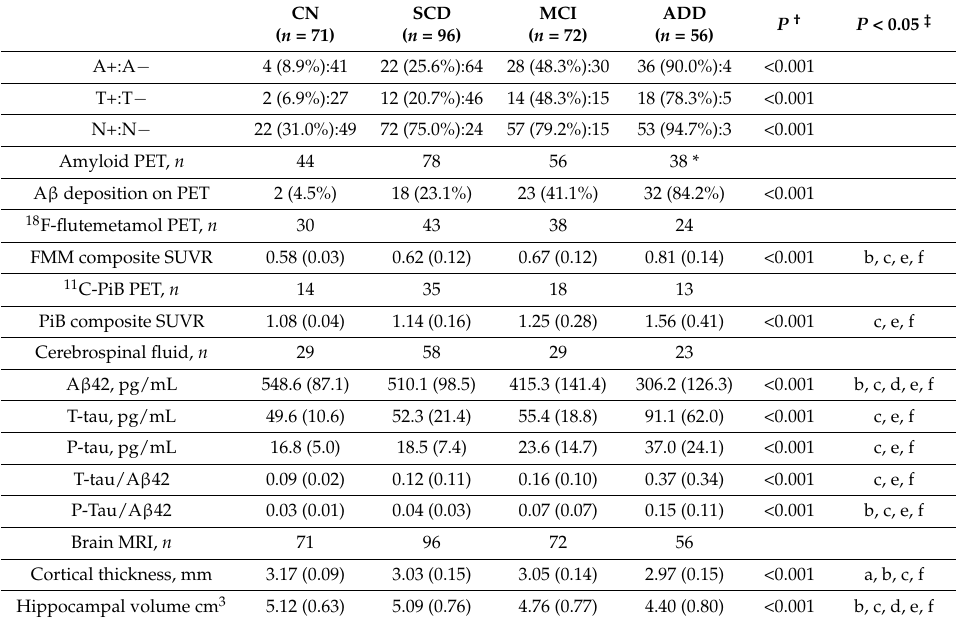
Table 5. Results of AD biomarkers according to the AD clinical spectrum.